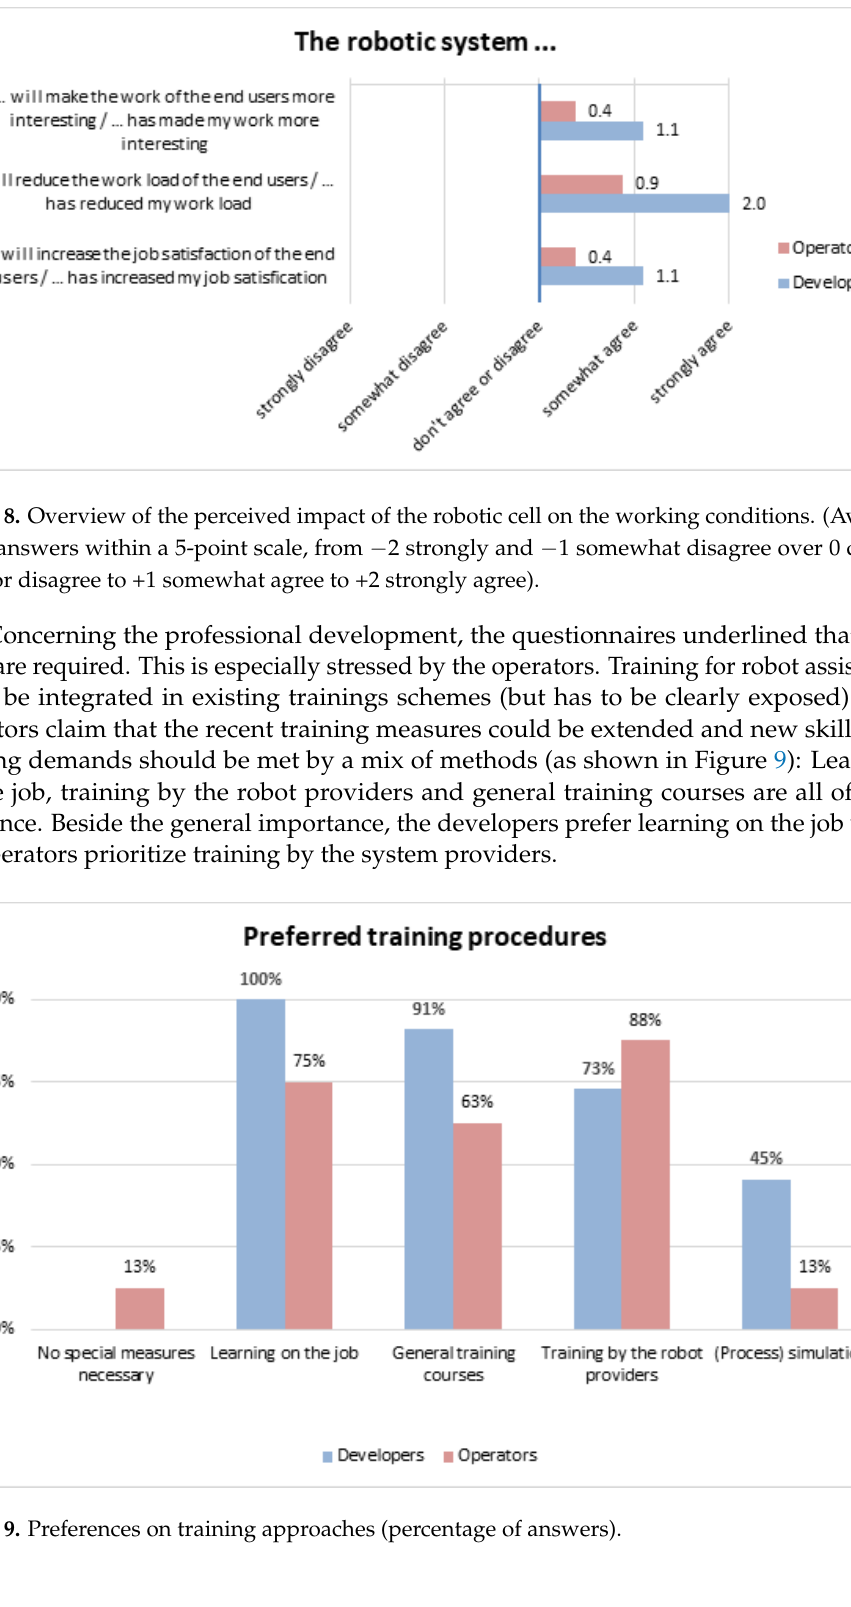
Figure 7. Overview of the perceived impact of the robotic cell on the working conditions. (Average of the answers within a 5-point scale, from −2 strongly and −1 somewhat disagree over 0 do not agree or disagree to +1 somewhat agree to +2 strongly agree)